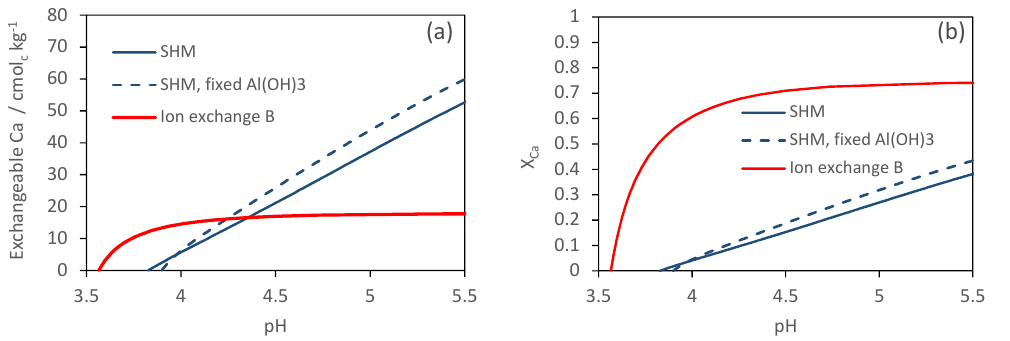
Figure 5. Model-simulated Ca(OH) 2 titration of the Gårdsjön O horizon with three different models. (a) Exchangeable Ca 2 + as a function of pH, and (b) X Ca (the fraction of exchangeable Ca 2 + to the total number of binding sites) as a function of